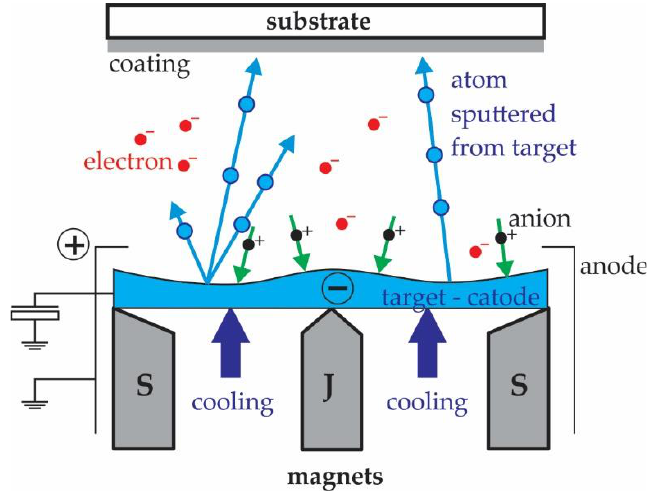
Figure 1. The principle of magnetron sputtering [41].